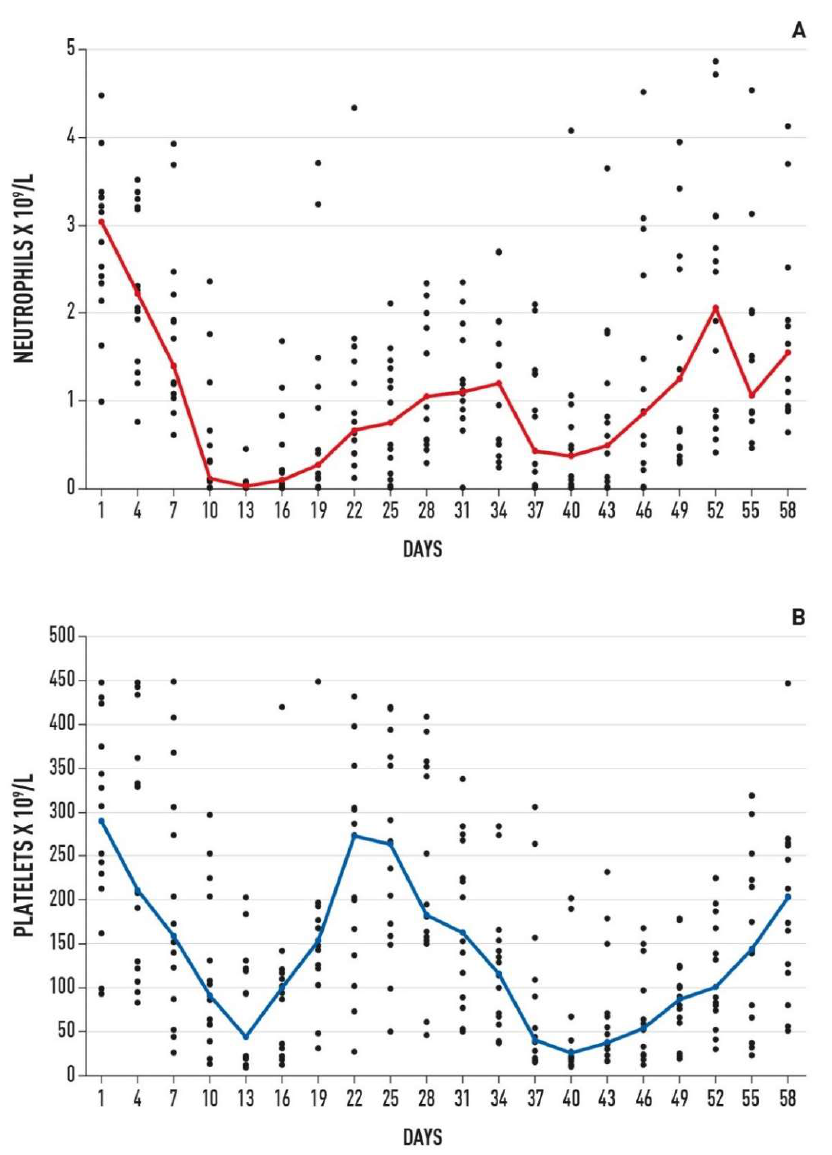
Figure 2. Hematologic toxicity of the 15 patients included in the study. Median and individual neu- trophil ( A ) and platelet ( B ) values over time during and after treatment.